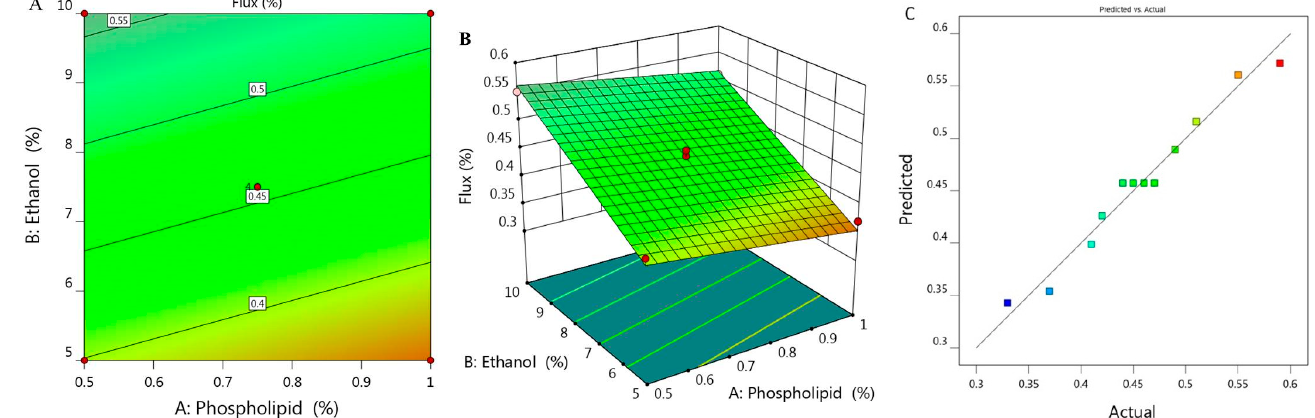
Figure 3. ( A ) 2D contour graph, ( B ) 3D response surface plot demonstrating the influence of independent variables (X 1 ) and (X 2 ) on the flux (Y 3 ) and ( C ) linear correlation plot between actual and predicted values for response (Y 3 ).